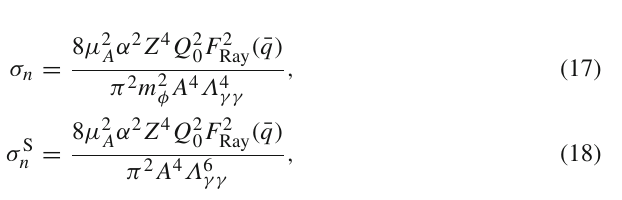
Fig. 4 The 3 σ reaches with unpolarized e ± beams in the m φ,χ − Λ panels assume Λ γγ -only, Λ γ Z -only and Λ γ Z = Λ γγ cases. P T (γ) cut plane. The blue, red and green solid/dotted/dashed lines denote scalar is at 35 (45)GeV for 91.2 (240)GeV runs for scalar DM, P T (γ) cut is DM, fermion DM with scalar and pseudo-scalar types, respectively, at 30 (35)GeV for 91.2 (240)GeV runs for fermion DM that optimizes √ s = 91.2GeV at where the solid, dotted and dashed lines denote the sensitivity for a low m φ,χ 2.5 ab − 1 , 25fb − 1 and 240GeV at 5 ab − 1 . The left, middle and right